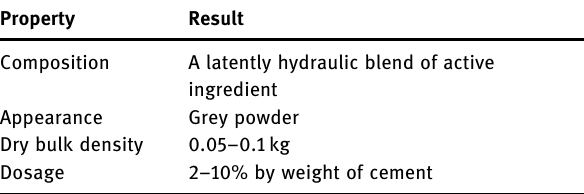
Table 8: Details of GF and